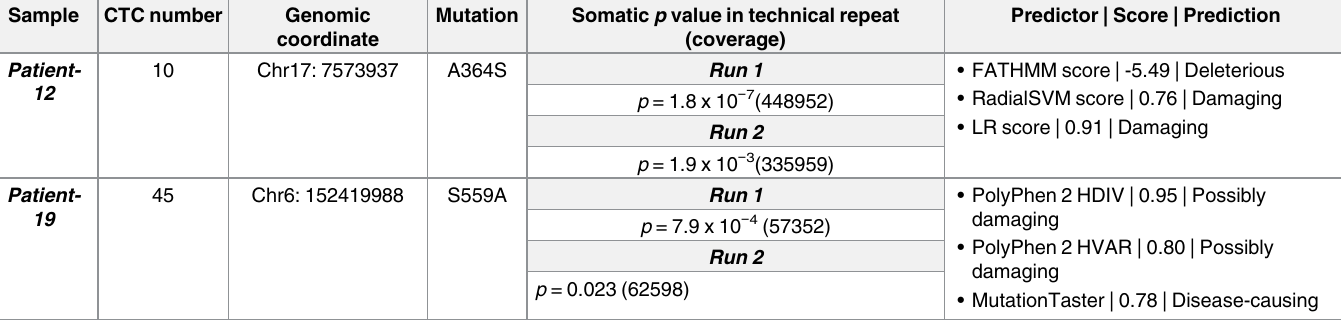
Table 1. Sequencing results for the CTC microfluidic outputs from